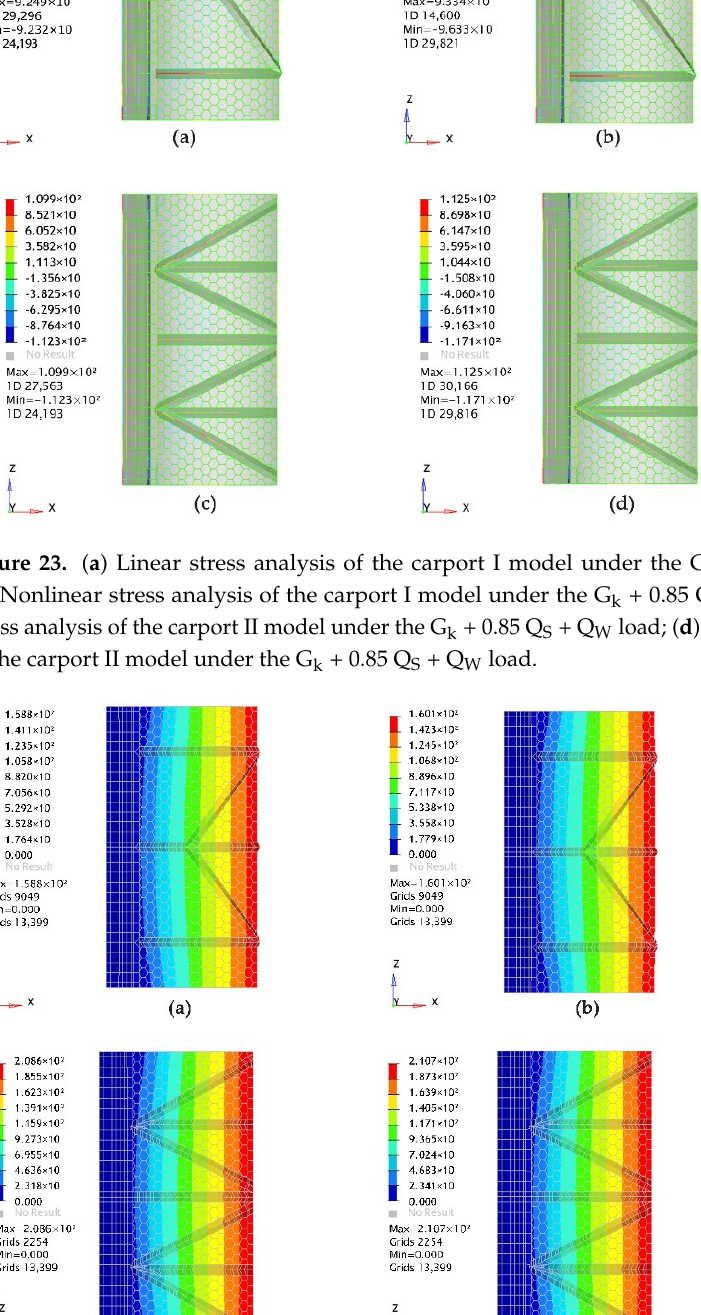
Figure 25. ( a ) Linear combined displacement analysis of carport I model under the G k + Q W load; ( b ) Nonlinear combined displacement analysis of carport I model under the G k + Q W load; ( c ) Linear combined displacement analysis of carport II model under the G k + Q W load; ( d ) Nonlinear com- bined displacement analysis of carport II model under the G k + Q W load.